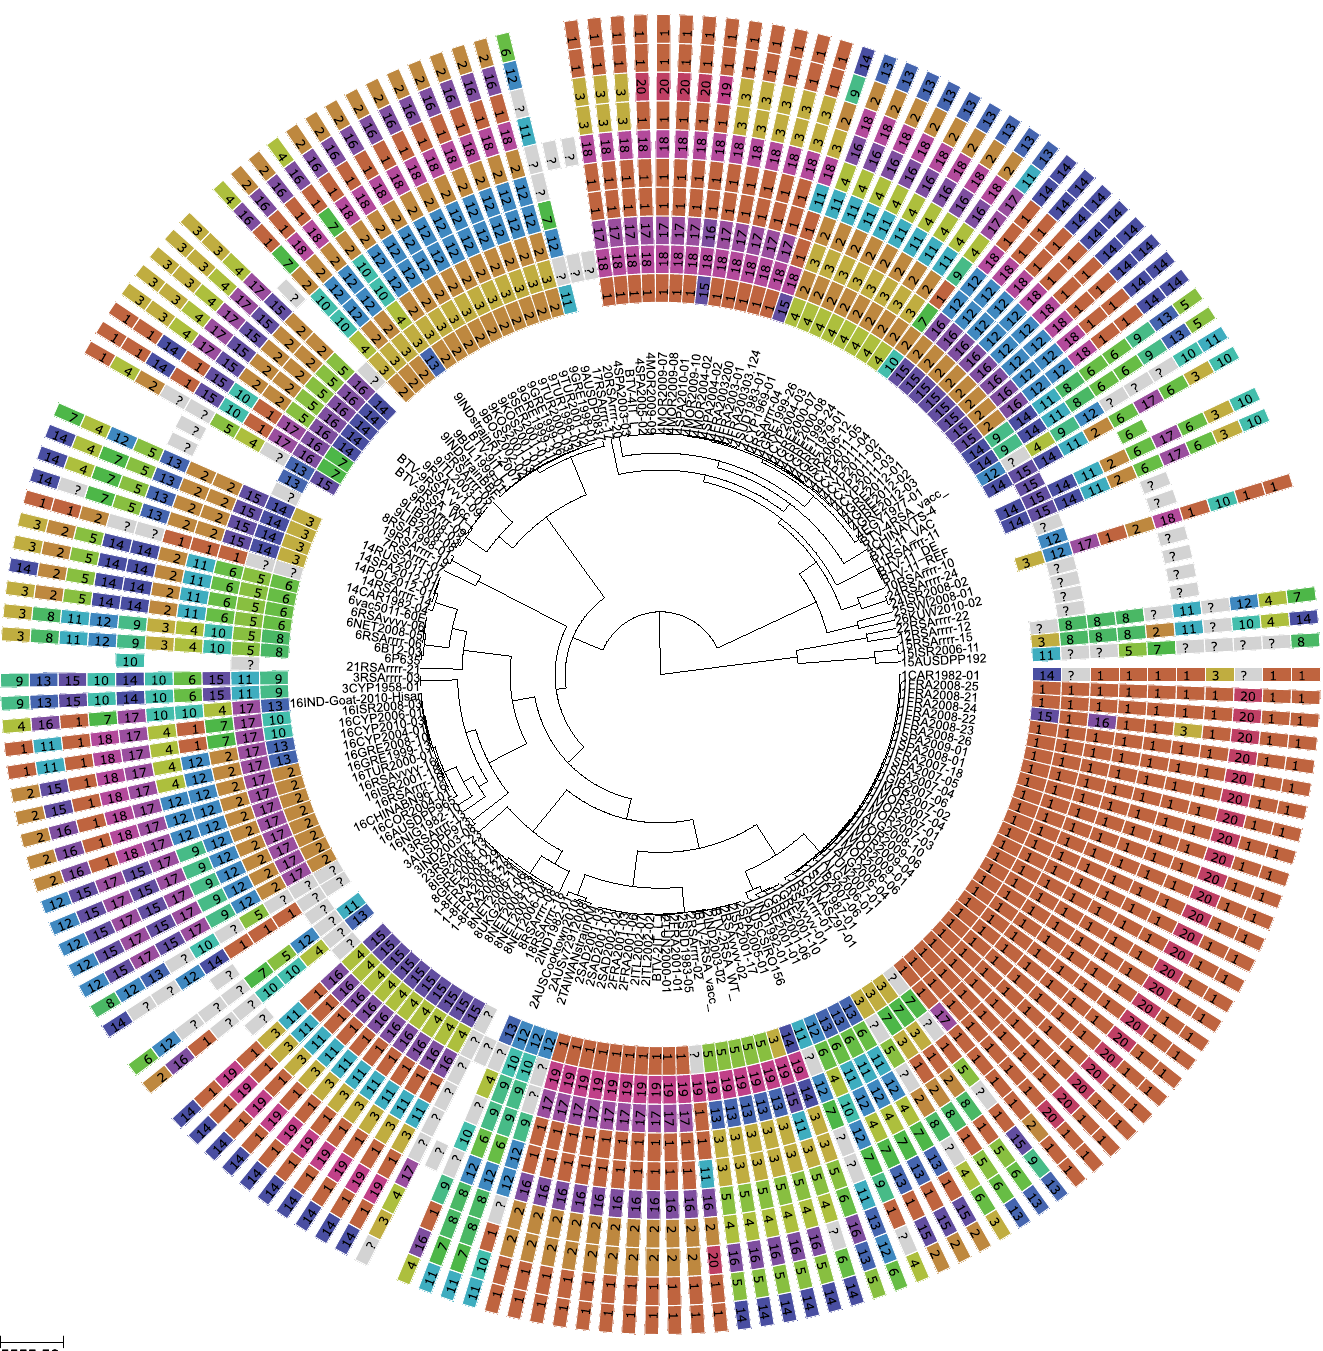
Fig 1. Phylogeny of BTV Seg-2 and inferred genomic reassortment patterns. Bayesian maximum clade credibility tree of 118 viruses from Europe and the Mediterranean region as well as 60 global viruses included for comparison. Cluster assignment of each segment based on phylogenetic lineages identified using Cluster Picker [46]. Sequences of the same segment that were assigned to the same cluster are indicated by shared colours and numbers (with numbers being arbitrary and not corresponding to serotype). There is no significance to sequences from different segments sharing the same colour or number. For some reference strains, only data for Seg-2 and Seg-6 were